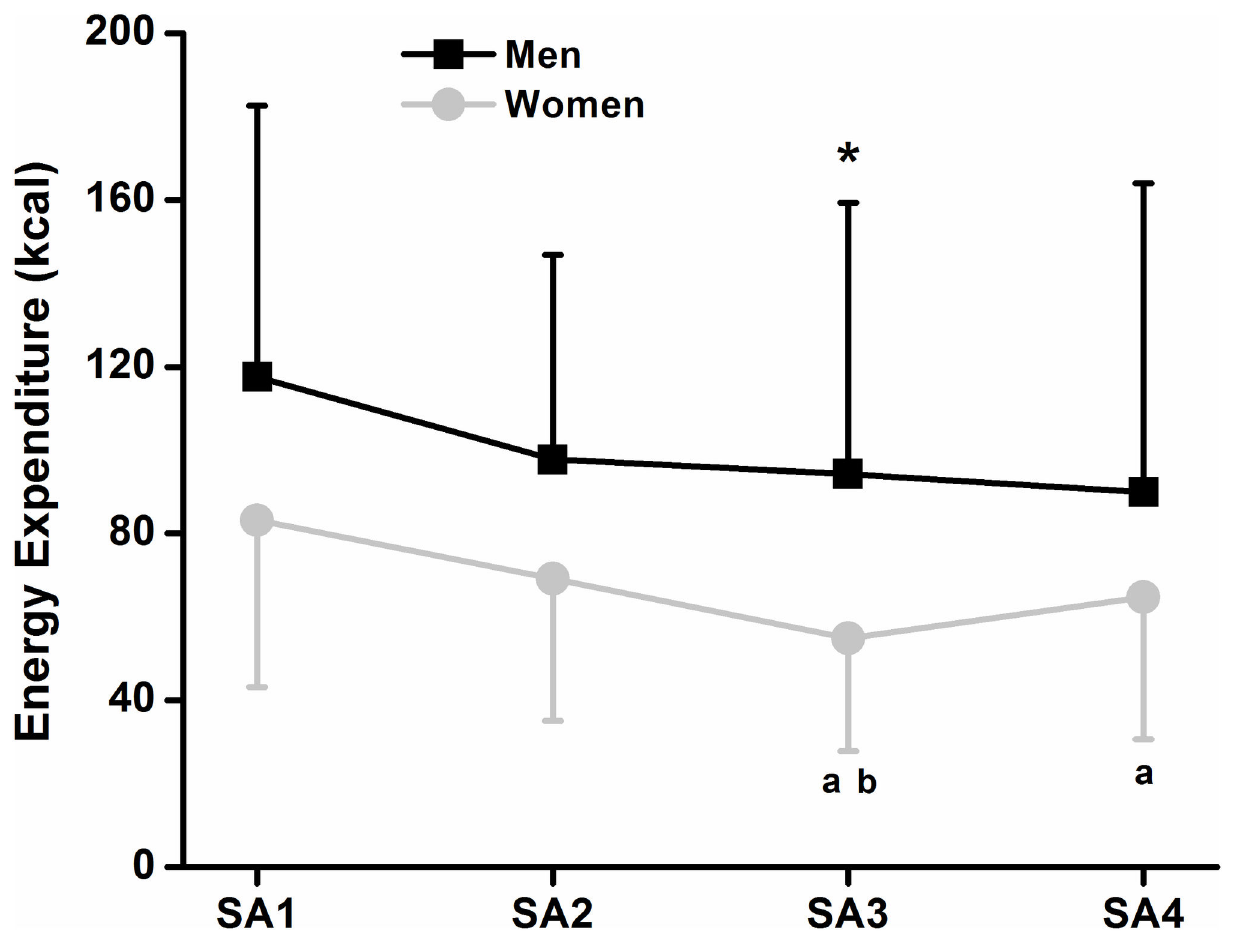
Figure 2. Differences in energy expenditure between all four sessions of sexual activity in men (black) and women (grey). Values are the mean ± SD. * Significantly different from the first session in men ( P < 0.05). a Significantly different from the first session in women ( P < 0.05). b Significantly different from the second session in women ( P < 0.05). SA: sexual